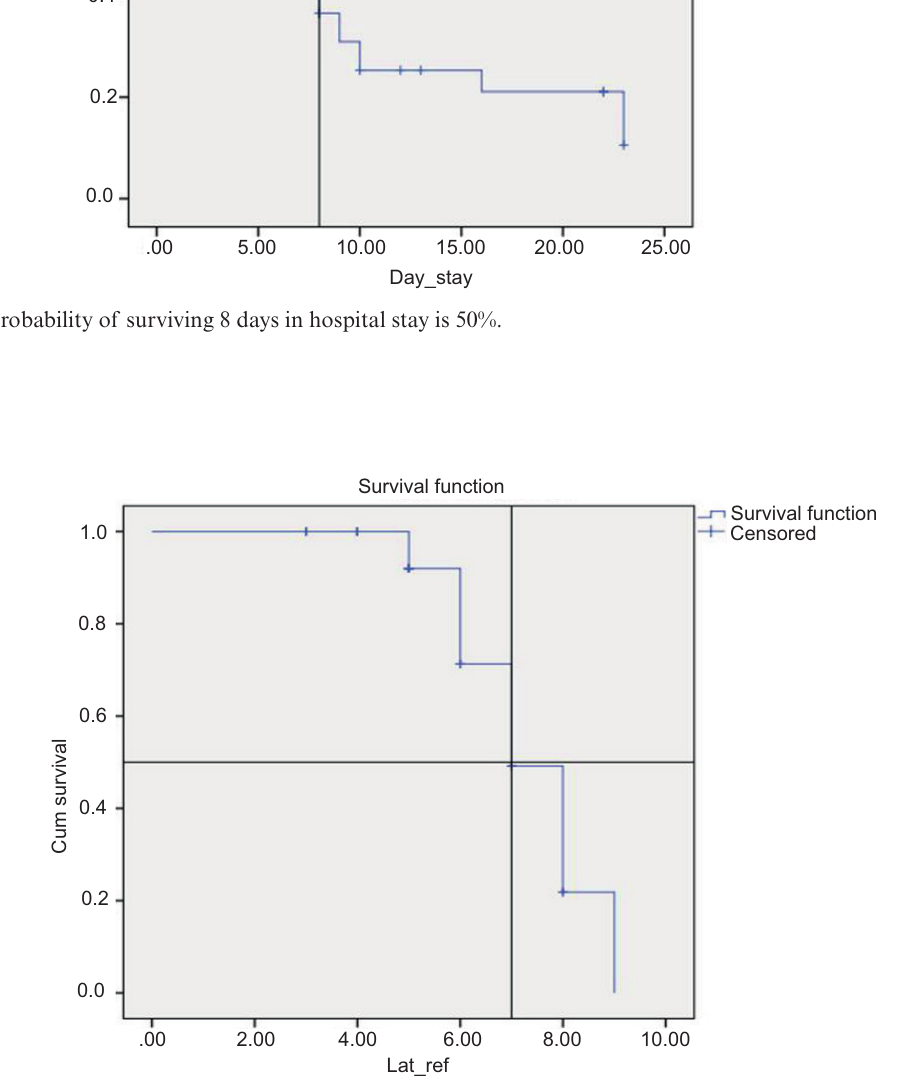
Figure 2: The probability of surviving 7 days in latent referral period is